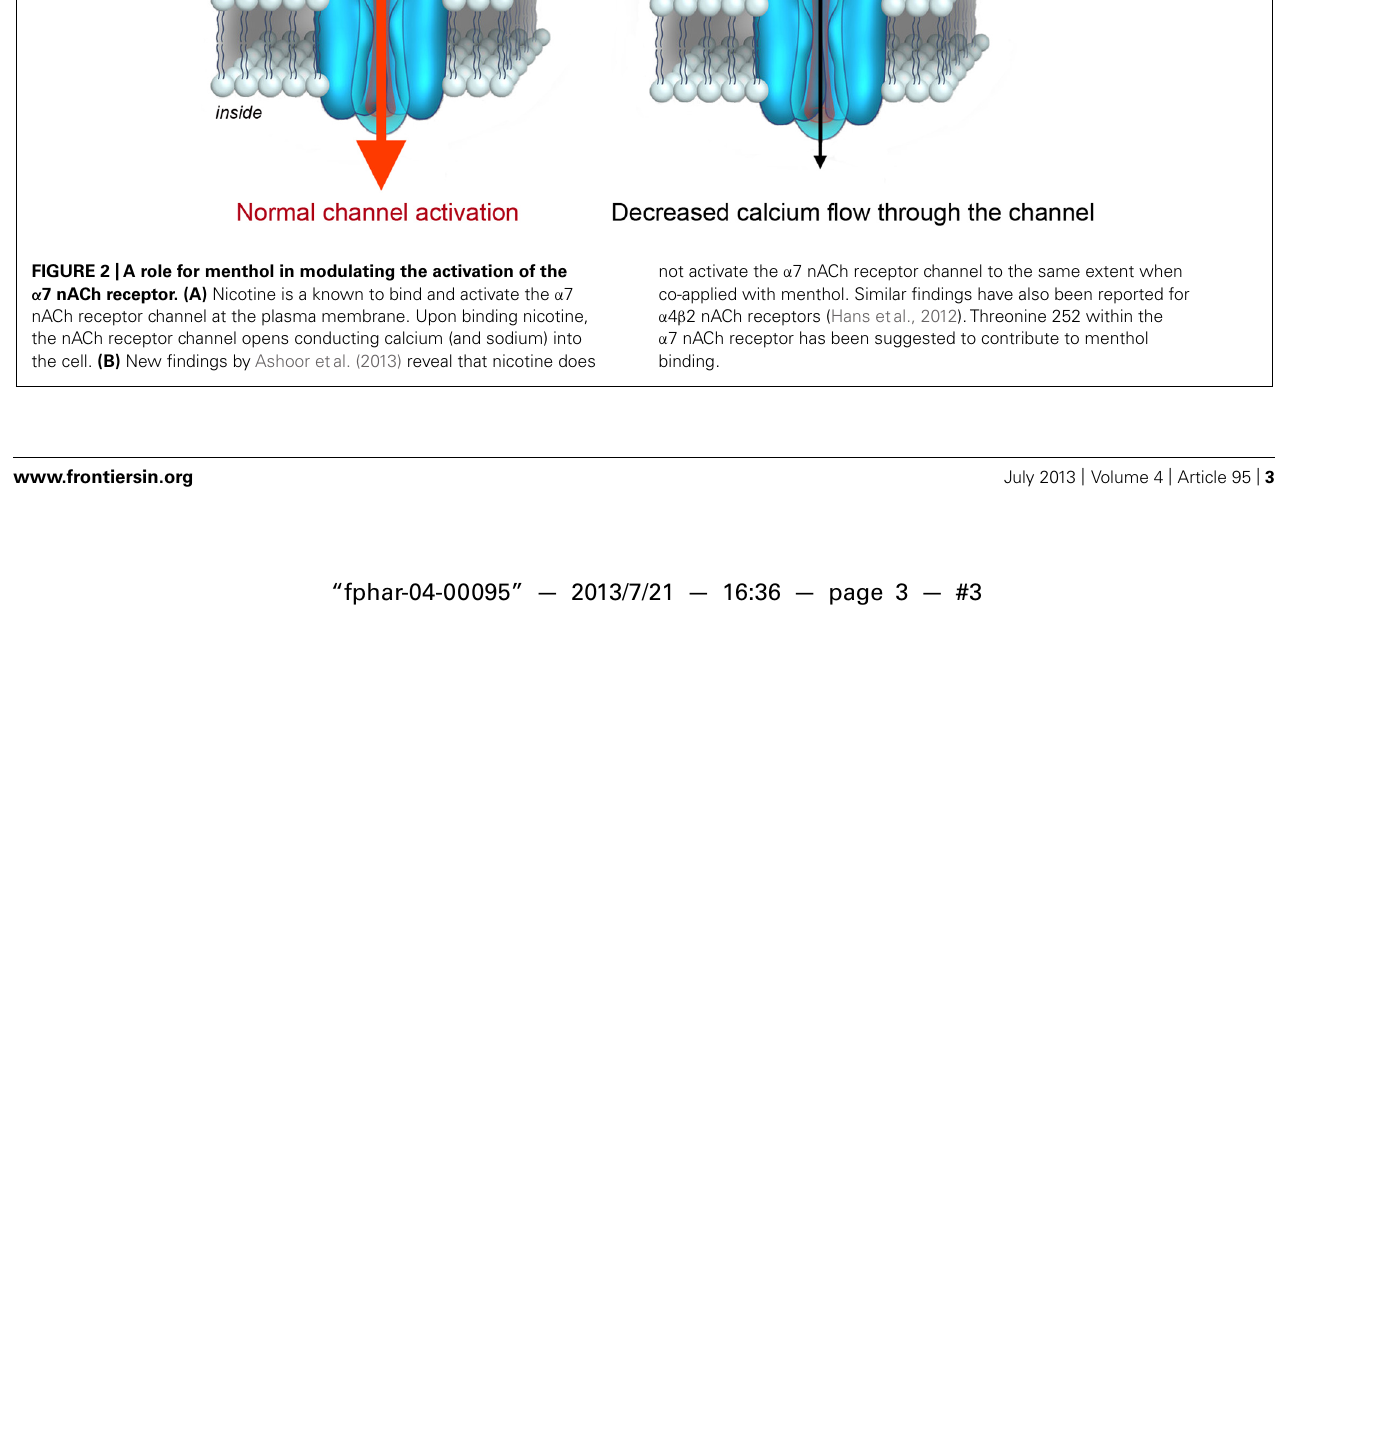
not activate the α 7 nACh receptor channel to the same extent when co-applied with menthol. Similar findings have also been reported for α 4 β 2 nACh receptors (Hans etal., 2012).Threonine 252 within the α 7 nACh receptor has been suggested to contribute to menthol